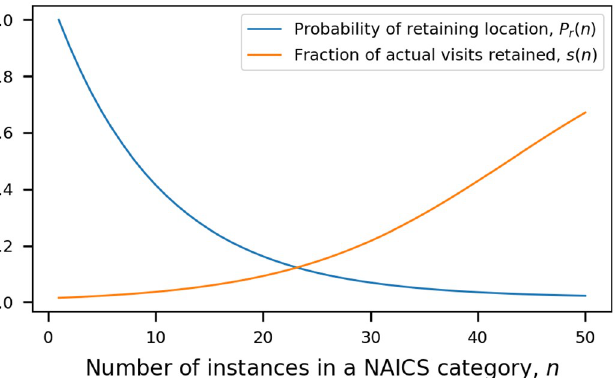
Fig 3. Scaling functions used to sample locations and the visits at each location. Scaling functions use N = 10 and s =